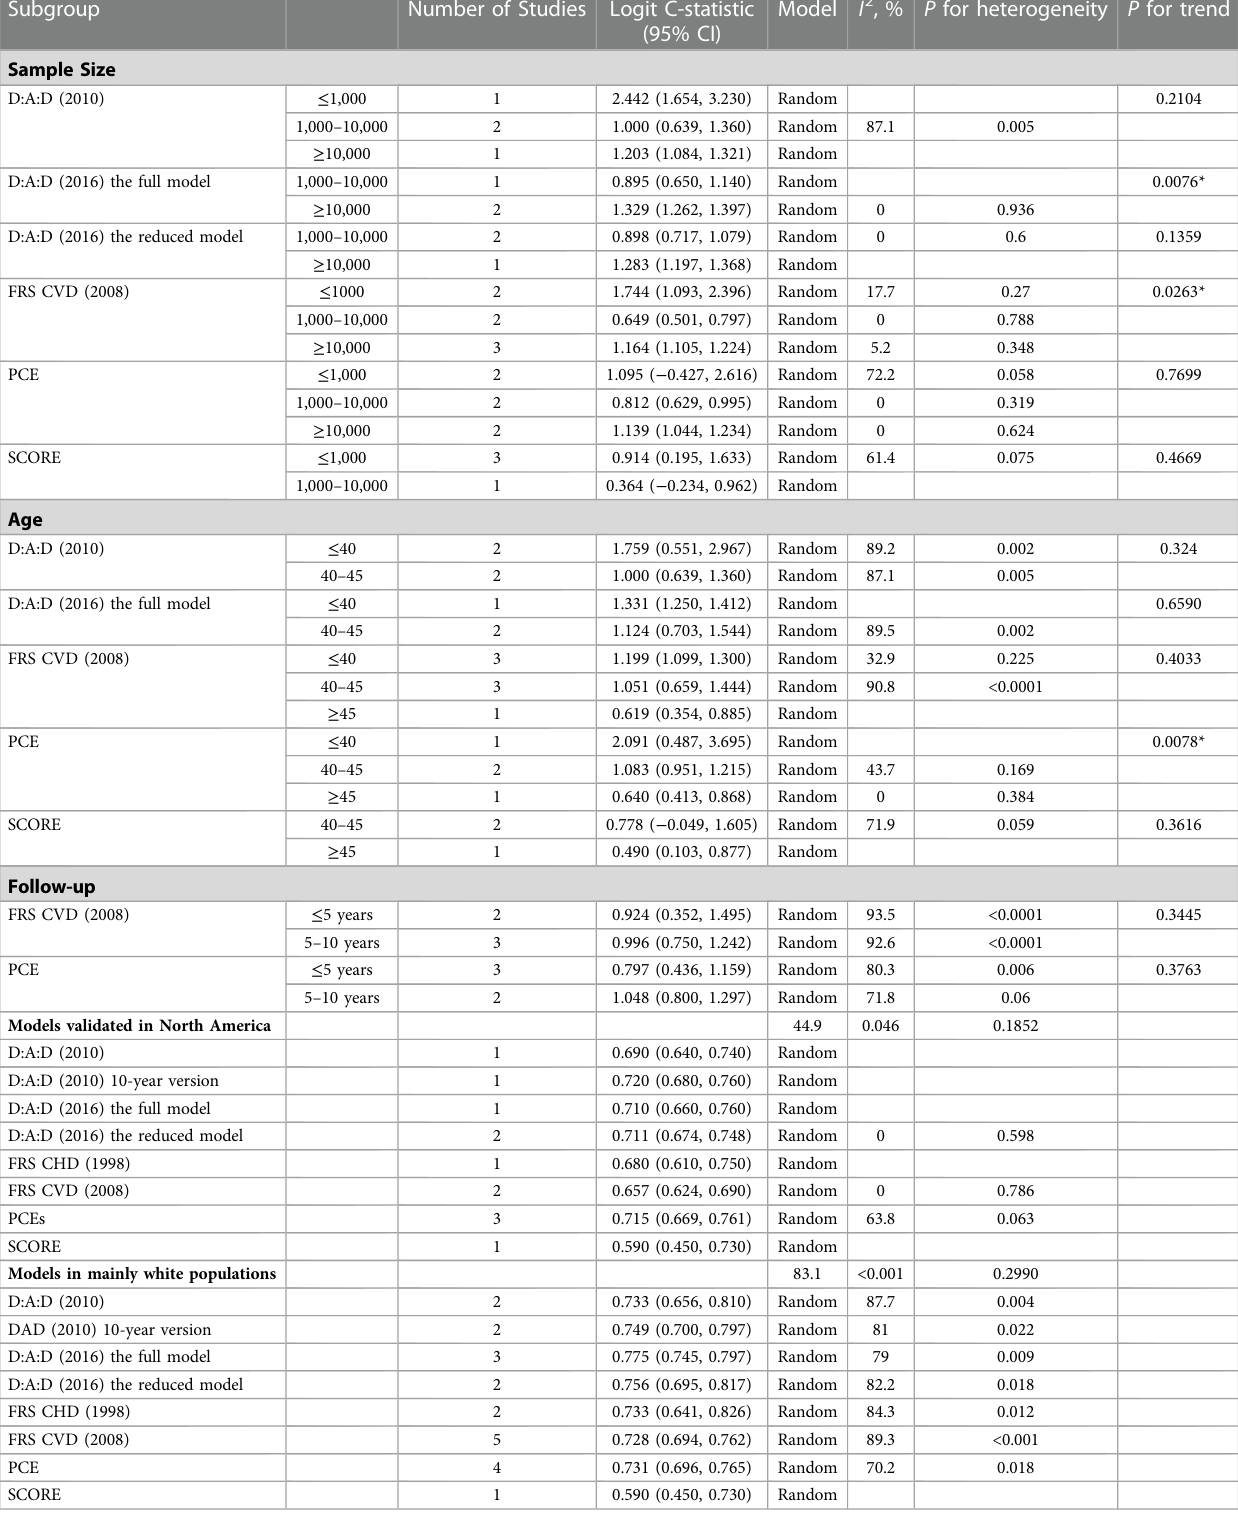
TABLE 4 Subgroup analysis of the C-statistics of the CVD prediction models for